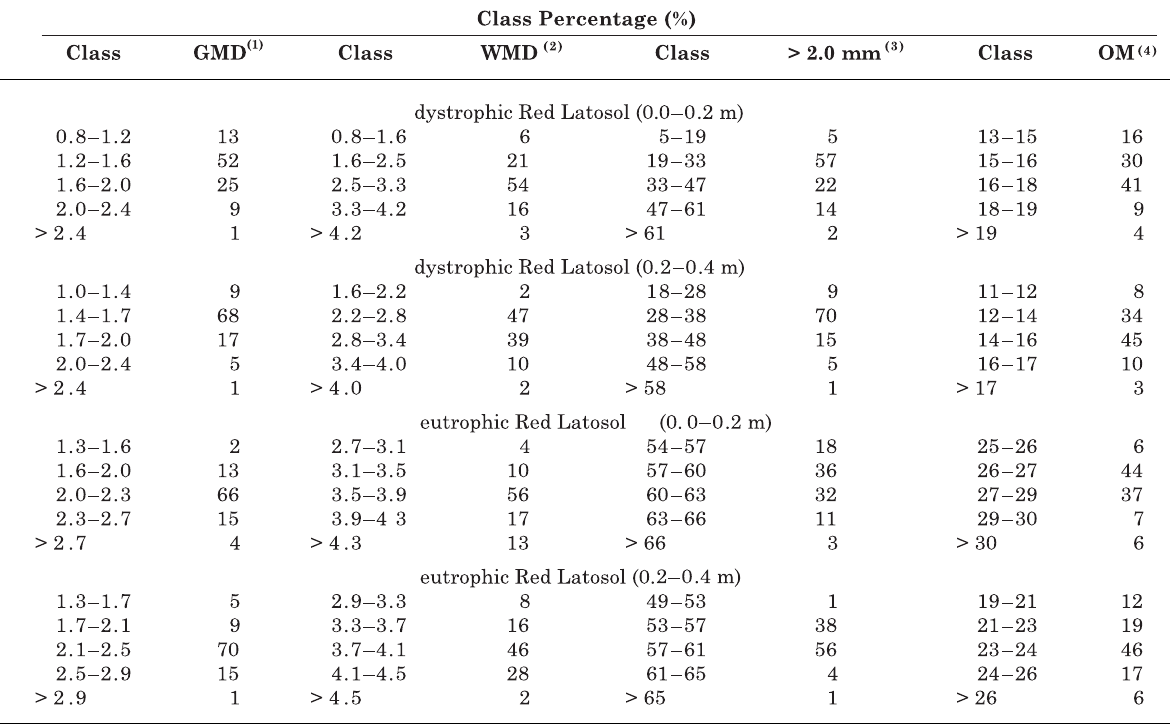
Table 3. Area percentage of each class for the properties geometric mean diameter (mm), mean weight diameter (mm), aggregates in class > 2.0 mm (%) and organic matter proportion (g dm -3 ), in an eutrophic Red Latosol and a dystrophic Red Latosol in layers of 0.0–0.2 and 0.2–0.4